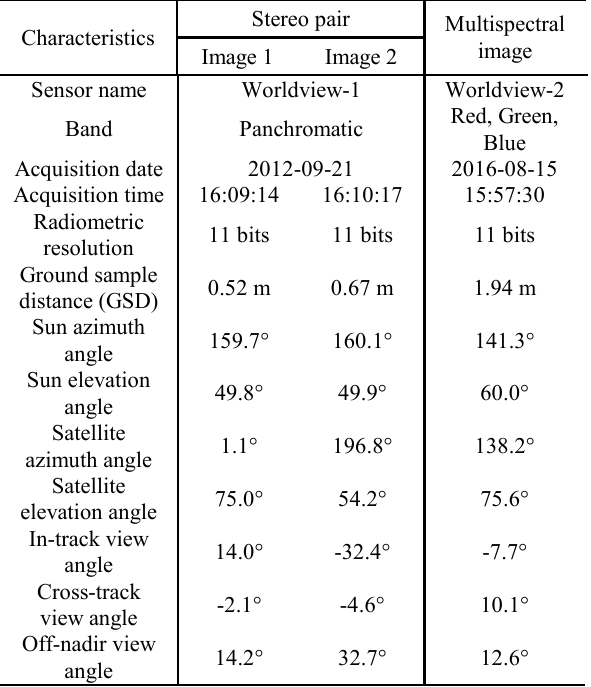
Table 1. Characteristics of the used stereo pair and multispectral